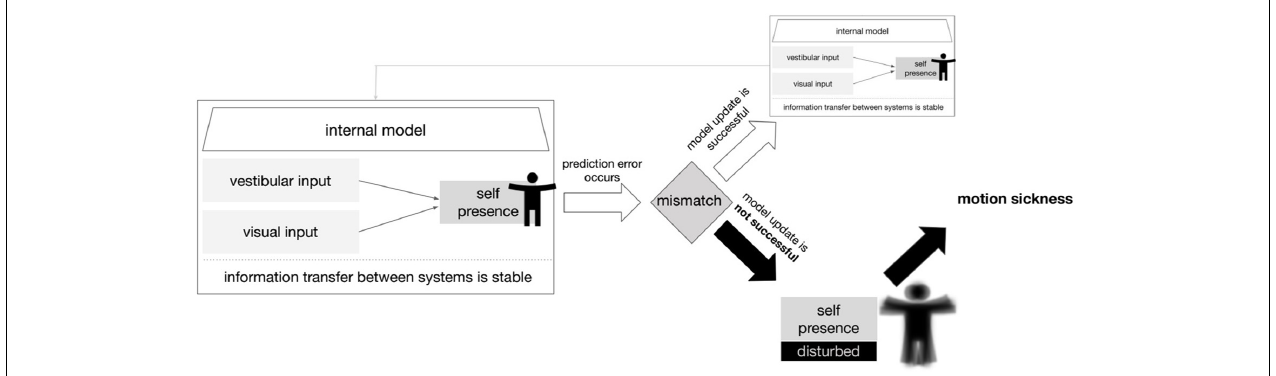
FIGURE 4 | Model of prediction error leading to motion sickness. A simplified scheme in which an update of the internal model is not possible due to a prediction error caused by the vestibular and visual inputs. The consequence for the organism is motion sickness. The term self-presence here describes the ability to perceive the self in physical space including motion in reference to Baumgartner et al.